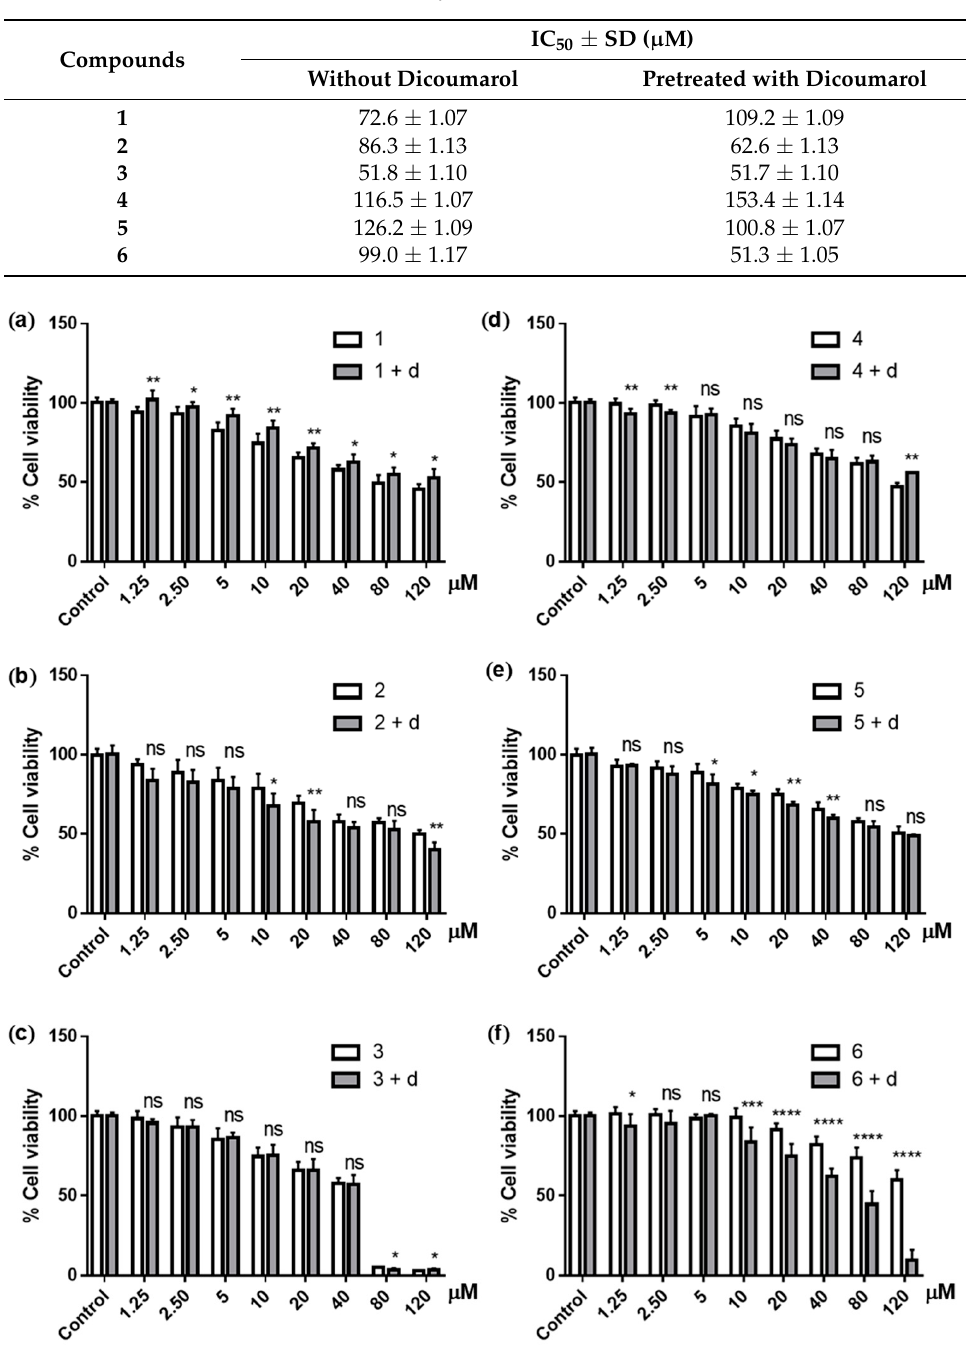
Figure 5. Cytotoxic effects of compounds 1 – 6 ( a – f , respectively) against PC3 cancer cells untreated (white bars) and 4-h pre-treated with 10 μ M dicoumarol ( d ; gray bars); ns = non-significant; * p ≤ 0.05; ** p ≤ 0.01; *** p ≤ 0.001; **** p ≤ 0.0001.